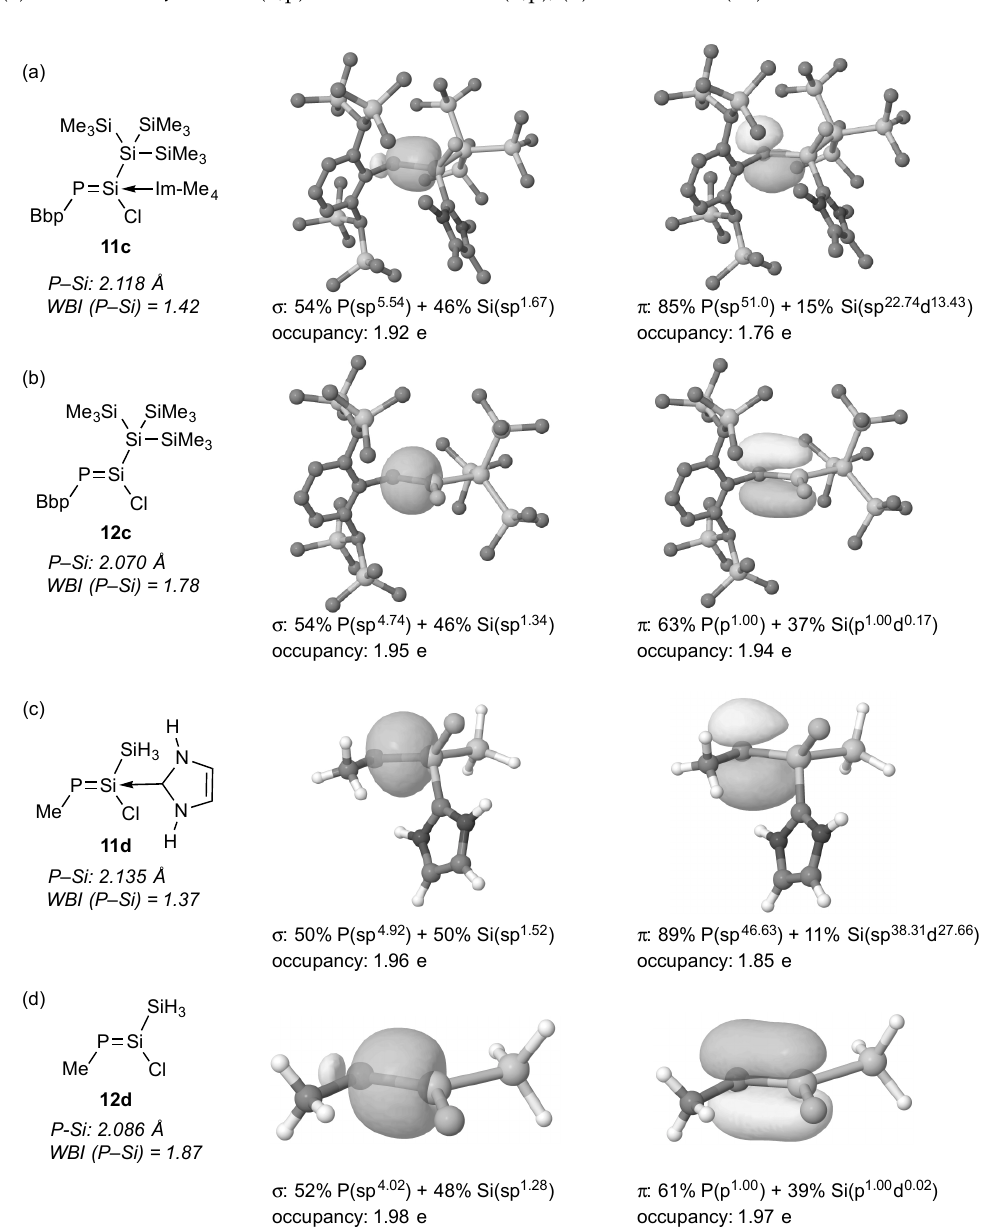
Figure 2. NBO (Natural Bond Orbital) calculations for NHC-coordinated and unligated phosphasilenes. ( a , b ) B3PW91/6-31+G(d,p)//B3PW91/3-21G(d), ( c , d ) MP2/6-311G(2d). WBI, Wiberg bond index.